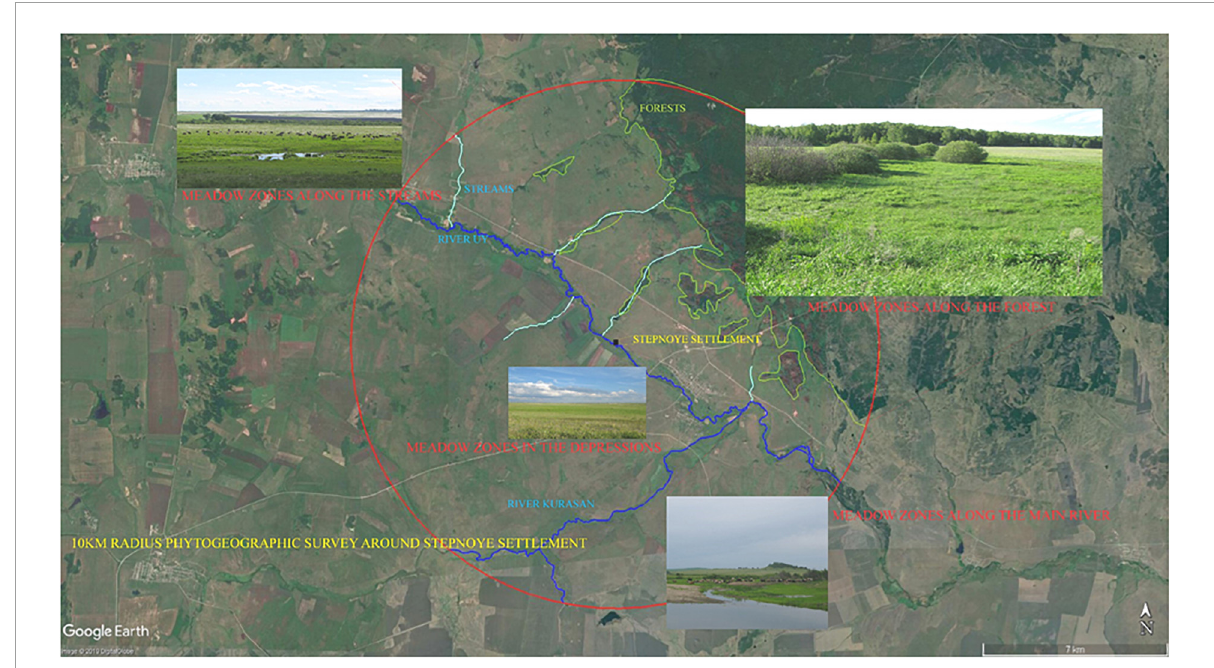
FIGURE7 Satellite image and photos denoting phytogeographical survey zone, associated meadow zones, and location of the Stepnoye Bronze Age settlement.